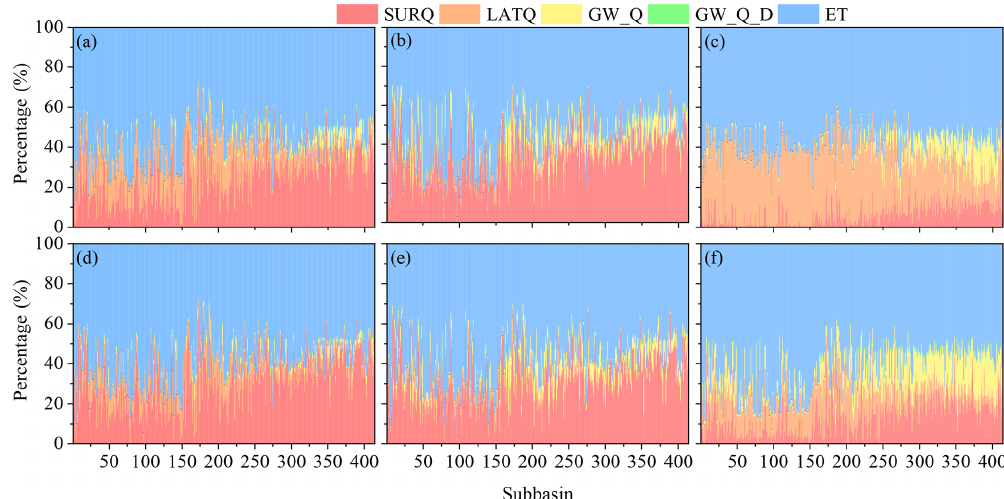
Figure 15. Water balance components for all subbasins derived from SWAT models using precipitation inputs of (a) Gauge, (b) CHIRPS, and (c) CPC at a monthly scale and (d) Gauge, (e) CHIRPS, and (f) CPC at a daily scale, where SURQ represents surface runoff Q surf , LATQ represents lateral flow Q lat , GW_Q is the baseflow from the shallow aquifer, GW_Q_D is the baseflow from the deep aquifer, and the sum of GW_Q and GW_Q_D equals Q gw . ET represents actual